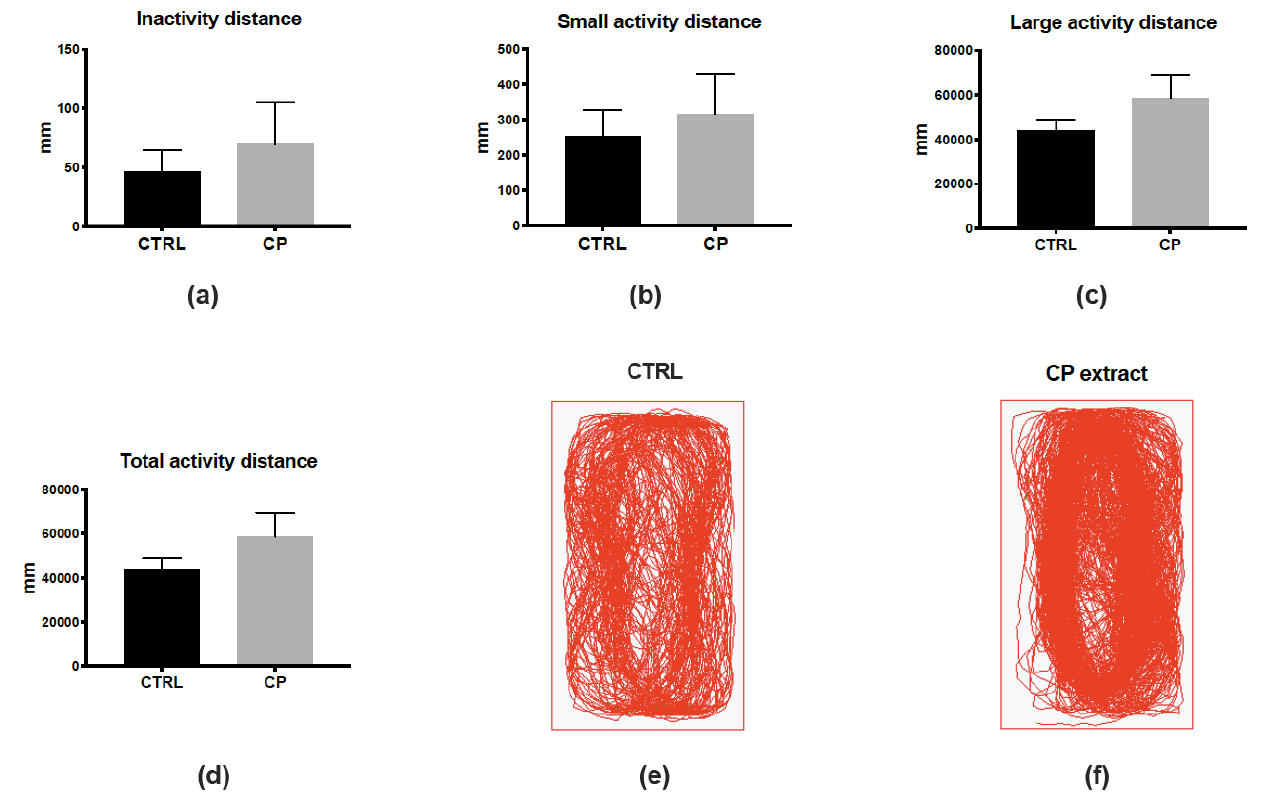
Figure 2. Cranberry pomace extract has no impact on finely tuned locomotor activity one day after injection. ( a – c ) Distance traveled in the “ inactive ” (<4 mm/s, ( a )), low activity (4 – 8 mm/s, ( b )), and high activity (>8 mm/s, c ) states during the 10-min recording period. ( d ) Total distance traveled by the fish during the recording period. Note that no significant differences were observed between groups. ( e , f ) Examples of paths traveled by control and CP-injected fish. n = 7 fish/group; data represent means ± SEM.